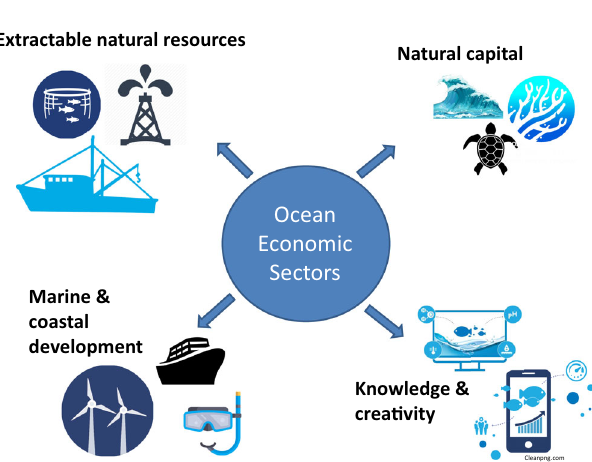
Fig. 2 Ocean economic sectors. Depiction of the four broad economic sectors that make up the ocean economy: extractable natural resources, natural capital, marine and coastal development, and knowledge and creativity.